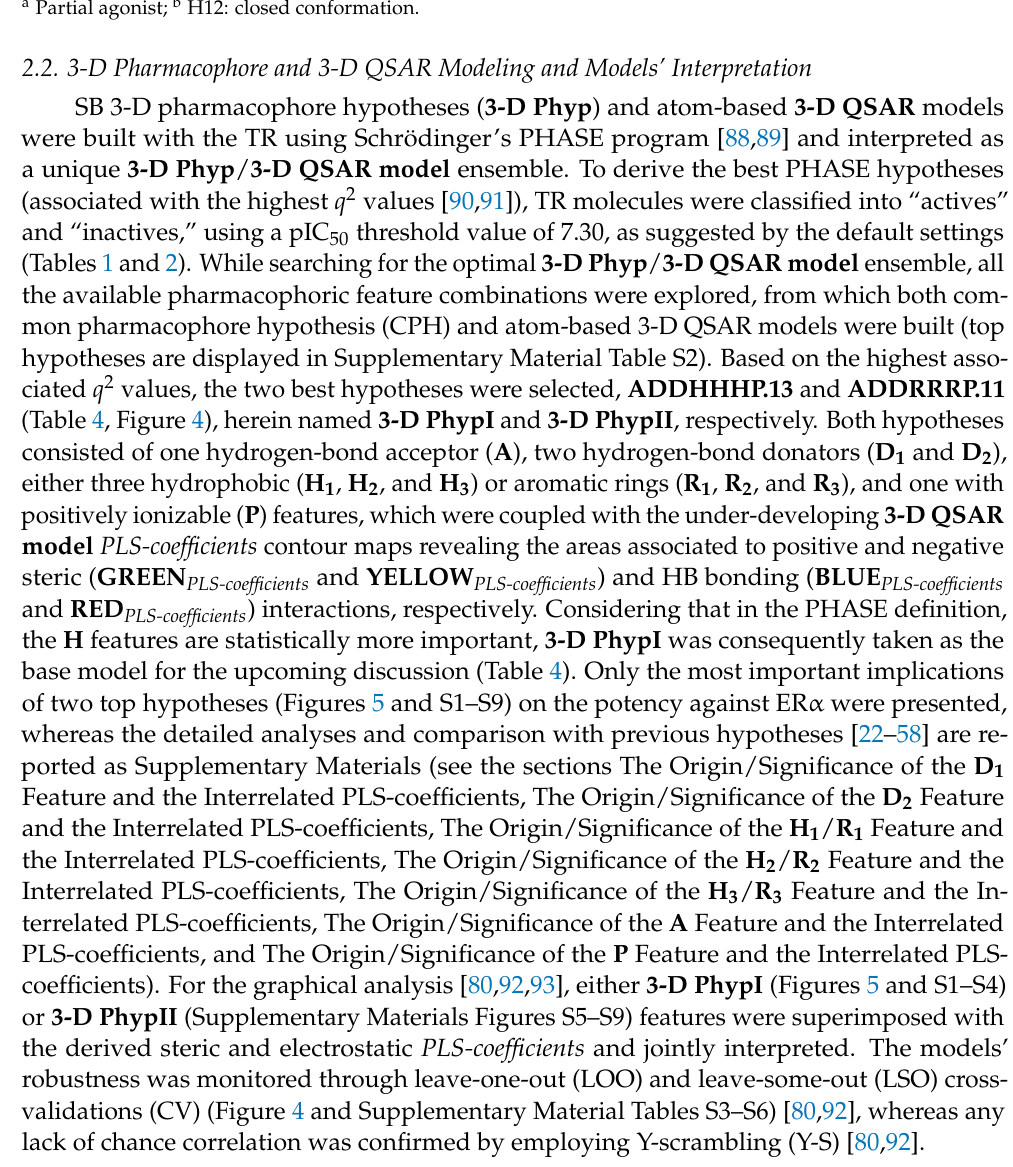
SB 3-D pharmacophore hypotheses ( 3-D Phyp ) and atom-based 3-D QSAR